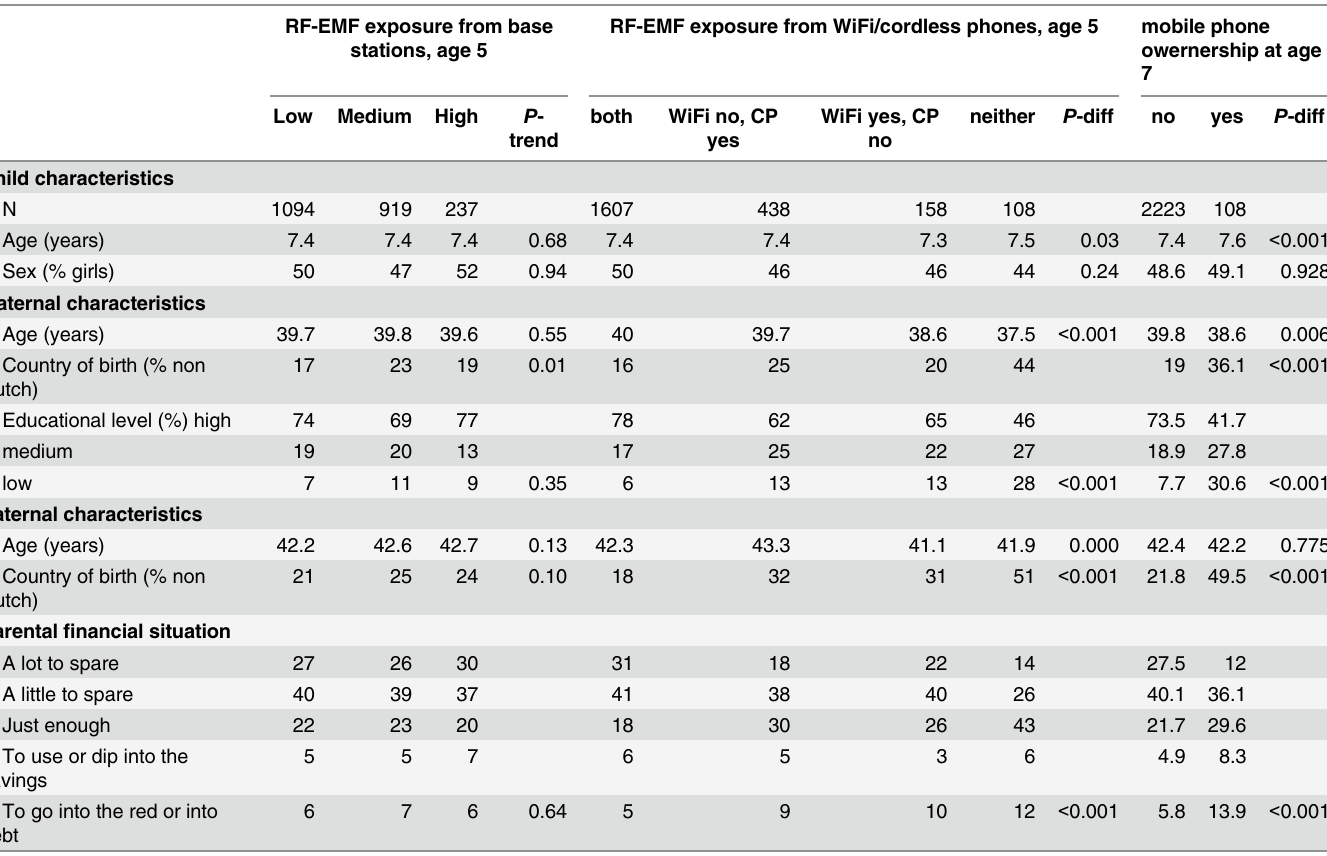
Table 1. Maternal, paternal, and child characteristics by RF-EMF a . RF-EMF exposure from base RF-EMF exposure from WiFi/cordless phones, age 5 mobile phone stations, age 5